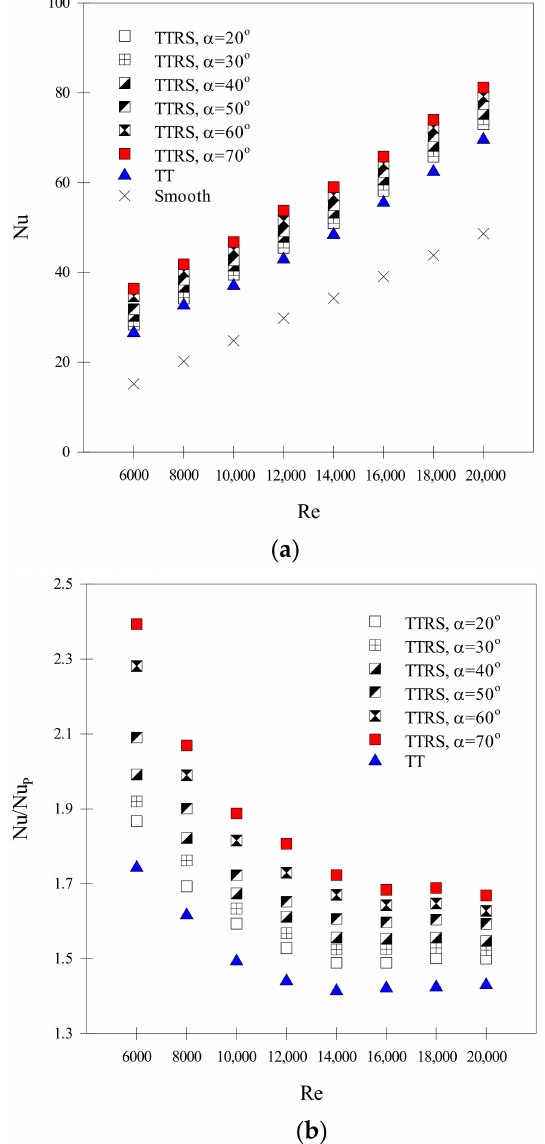
Figure 5. Effect of the twisted tapes in rib and sawtooth form vortex generator (TTRS) at varying sawtooth angles ( α ) on heat transfer enhancement. ( a ) Nu , ( b ) Nu / Nu p